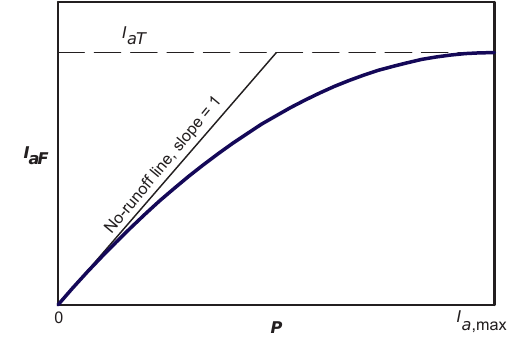
Figure 6. Variation of I aF with P for a continuous distribution such as the one shown in Fig. 5b.